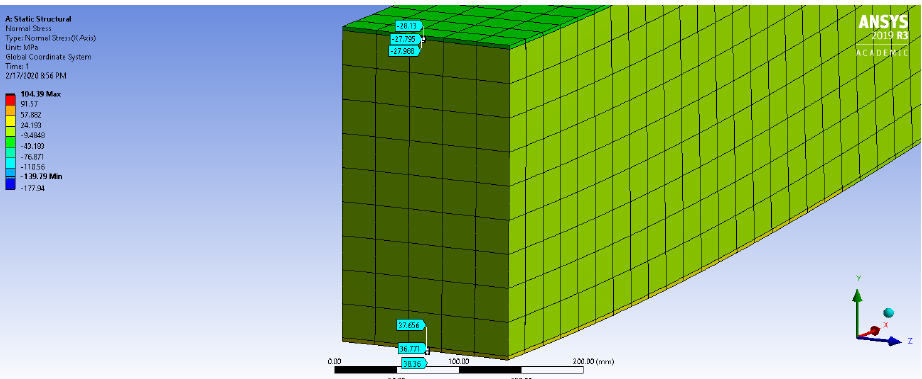
Figure 8. The mesh of the double plate beam is shown.